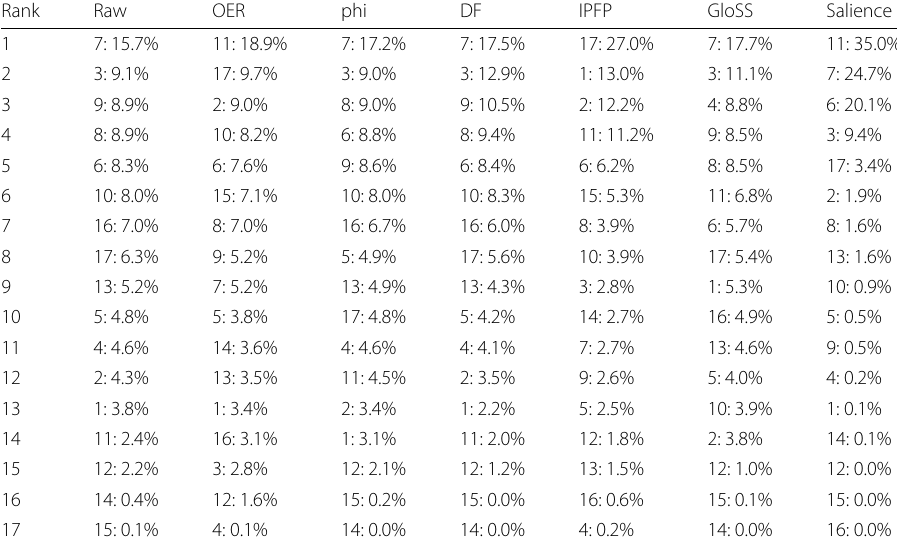
Table 21 Ranking of disease categories in terms of out-strength in the constructed networks Rank Raw OER